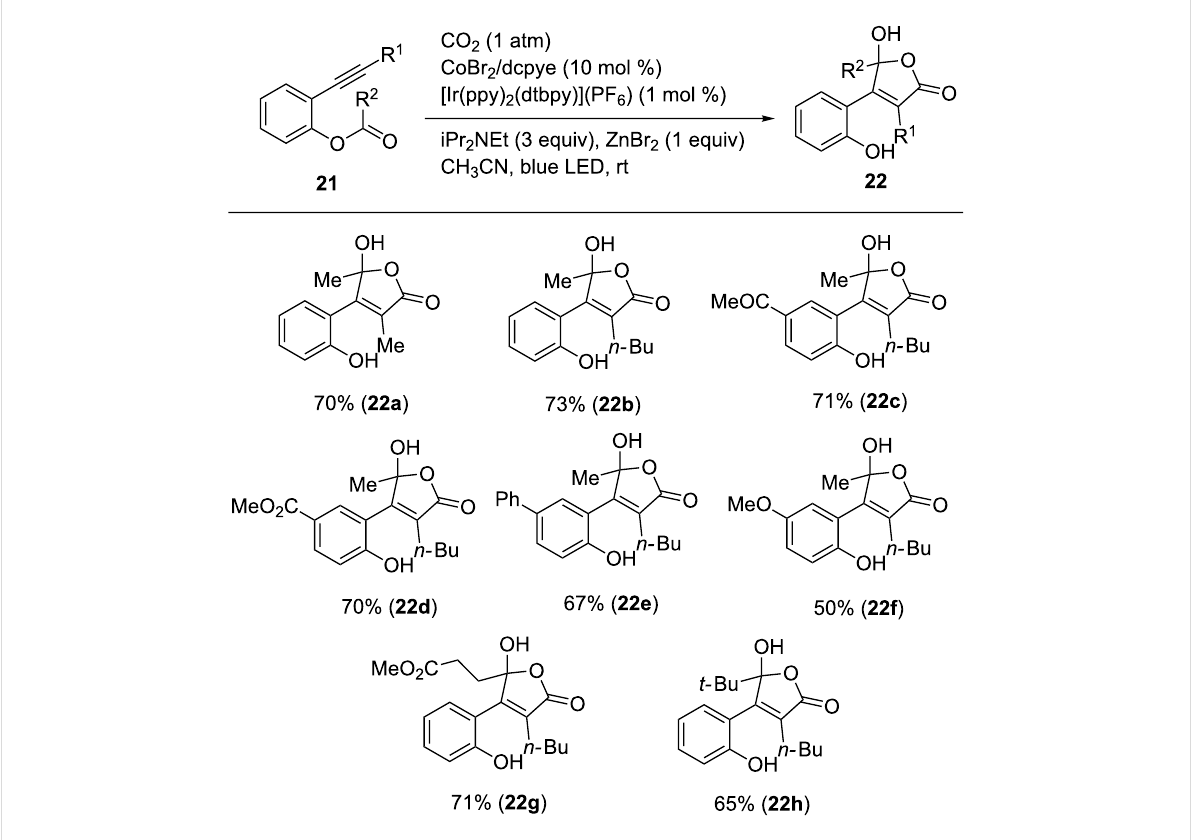
Scheme 21: Visible-light-driven synthesis of γ -hydroxybutenolides from ortho -ester-substituted aryl alkynes.